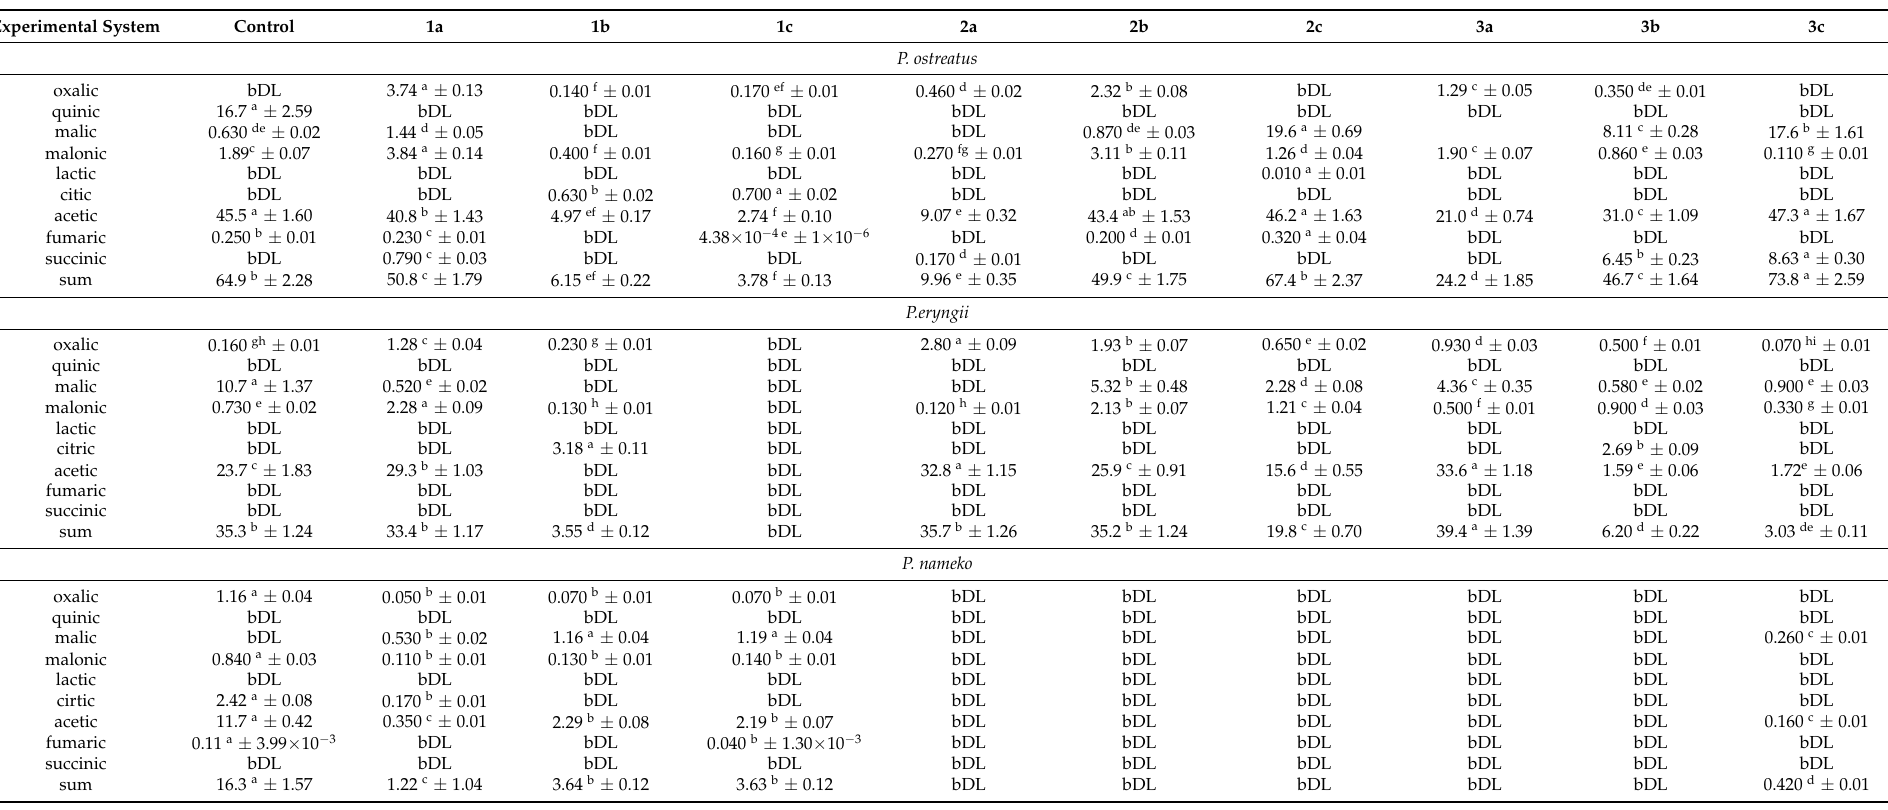
Table 5. Organic acids profile and content ( µ g g − 1 DW) of fruiting bodies of mushroom species under different Fe salts supplementation and